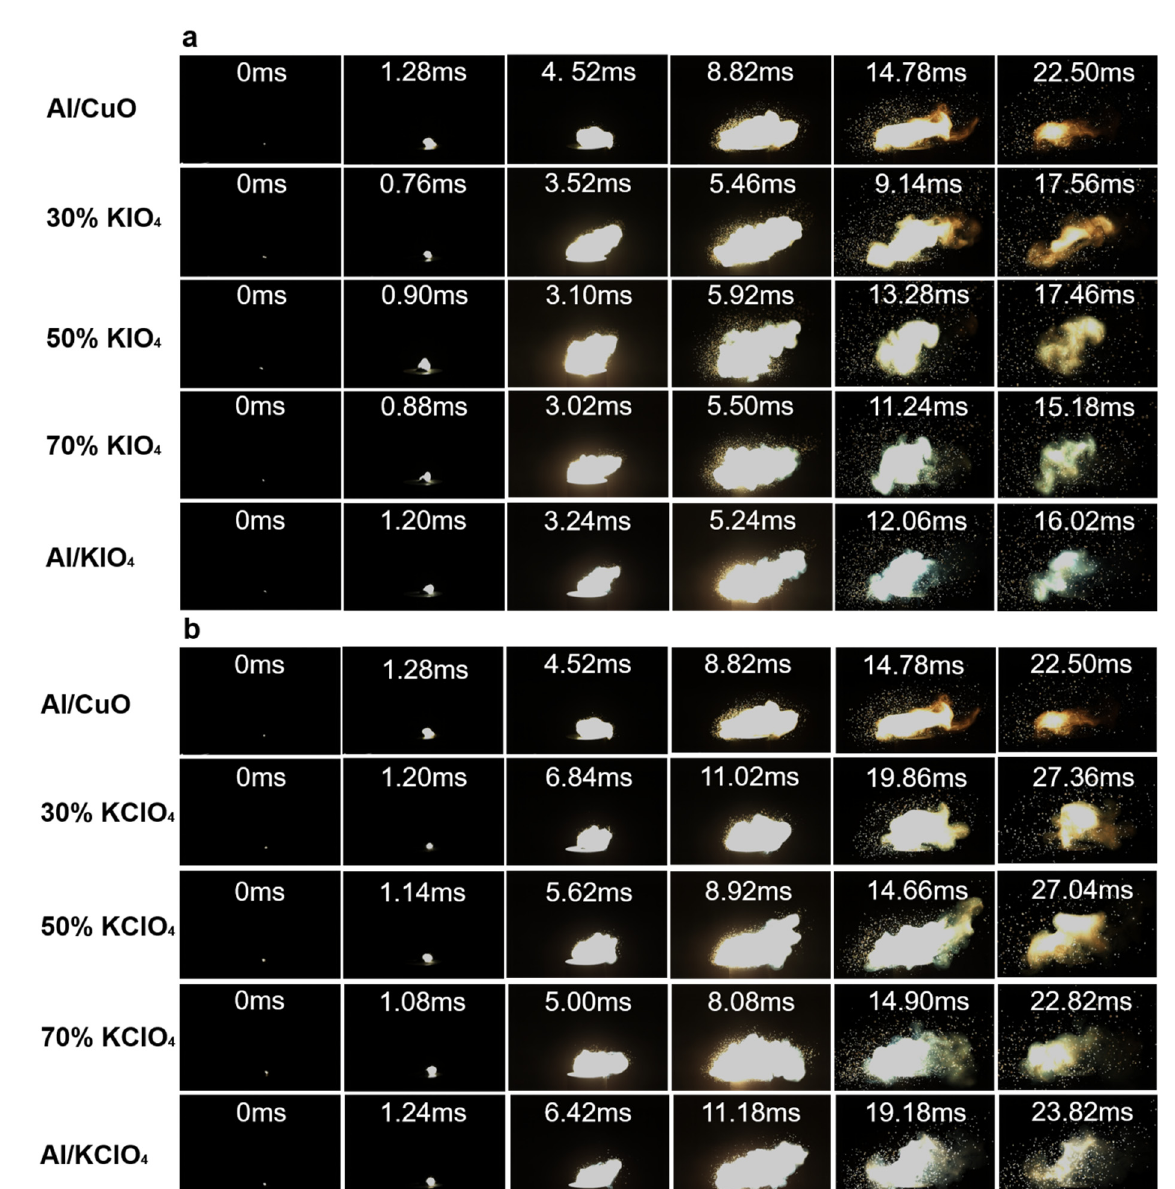
Figure 5. The combustion snapshots of ( a ) Al/CuO/xKIO 4 and ( b ) Al/CuO/xKClO 4 systems-based composites.